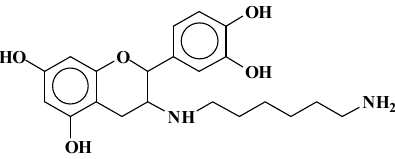
Figure 18. Covalently linked diamine onto C3 site of catechin.